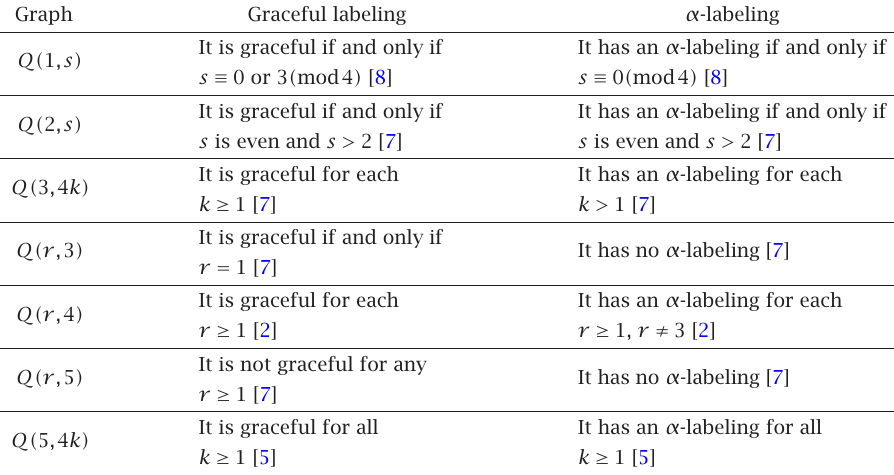
Table 1.1 . Some of the results about α -labelings of quadratic